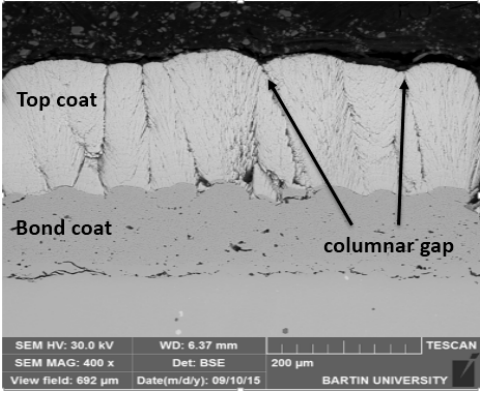
Figure 1. As-deposited cross-sectional microstructure of yttria-stabilized zirconia (YSZ) thermal barrier coating (TBC) system.